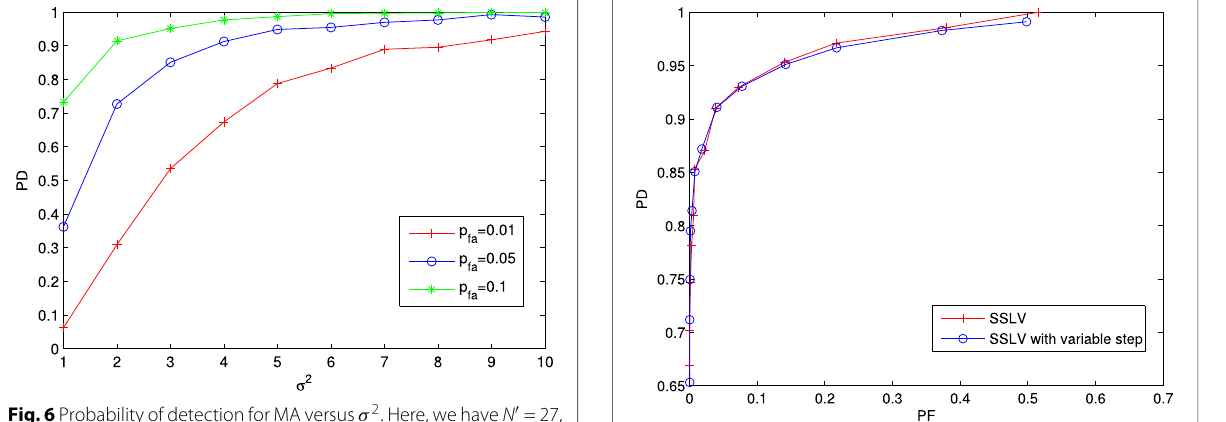
Fig. 8 ROC of SSLV and SSLV with variable step. Here, we have N (cid:2) = 27, b = 5, σ 2 = 1, σ w 2 = 4, p fa = 0.05, k = 6, M x = 3, and f ov = 5.